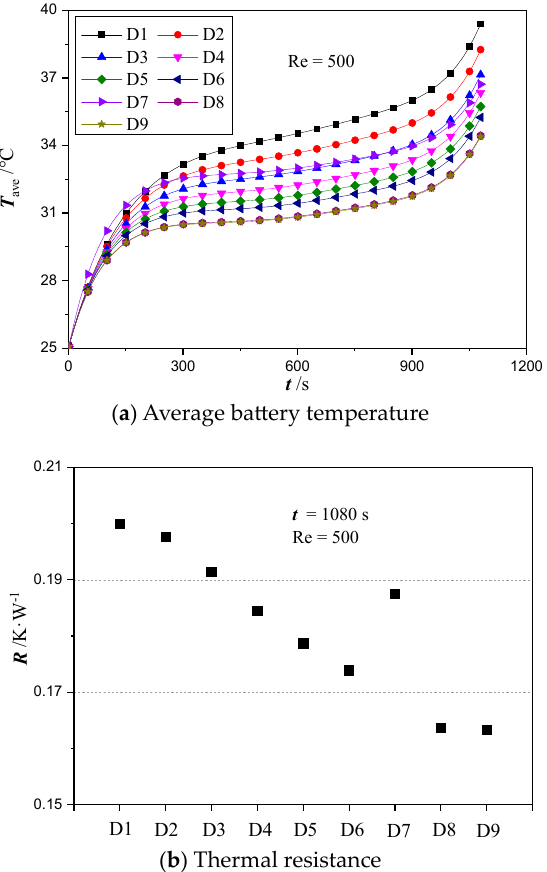
Figure 9. ( a ) The change of average temperature of battery surface during the discharging cycle and ( b ) thermal resistance for di ff erent cold plate designs at Re = 500. Non-uniform temperature distribution has a signi fi cant impact on ba tt ery perfor-